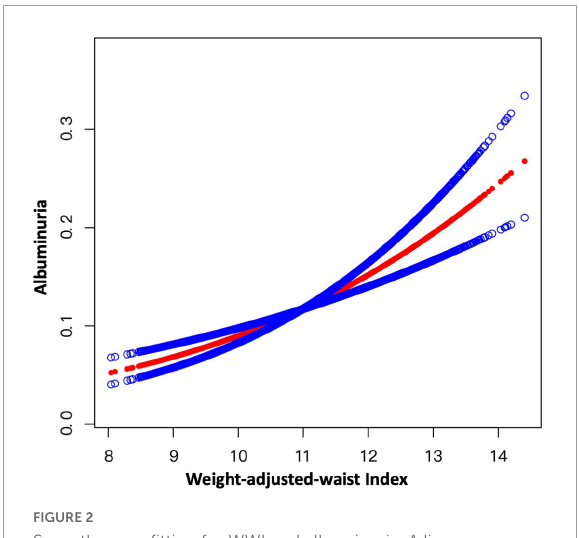
FIGURE2 Smooth curve fitting for WWI and albuminuria. A linear relationship between WWI and albuminuria was detected by the generalized additive model.